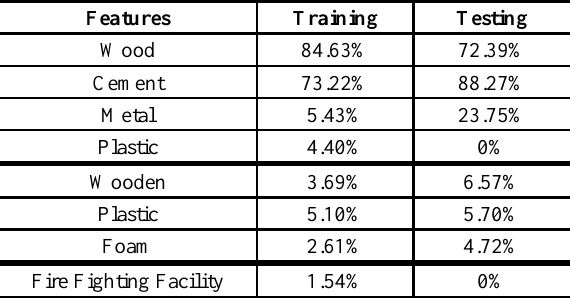
Table 3. Summary of features of the Training and Testing Data